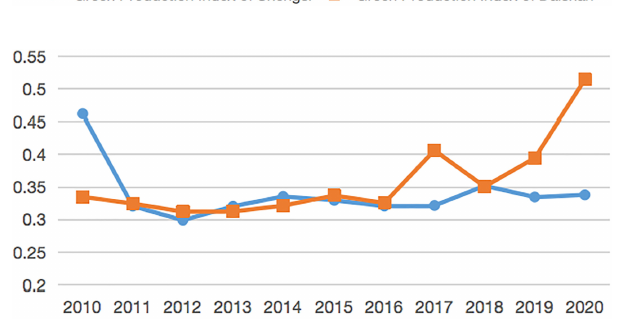
Figure 3. 2010 – 2020 Green production index evaluation results